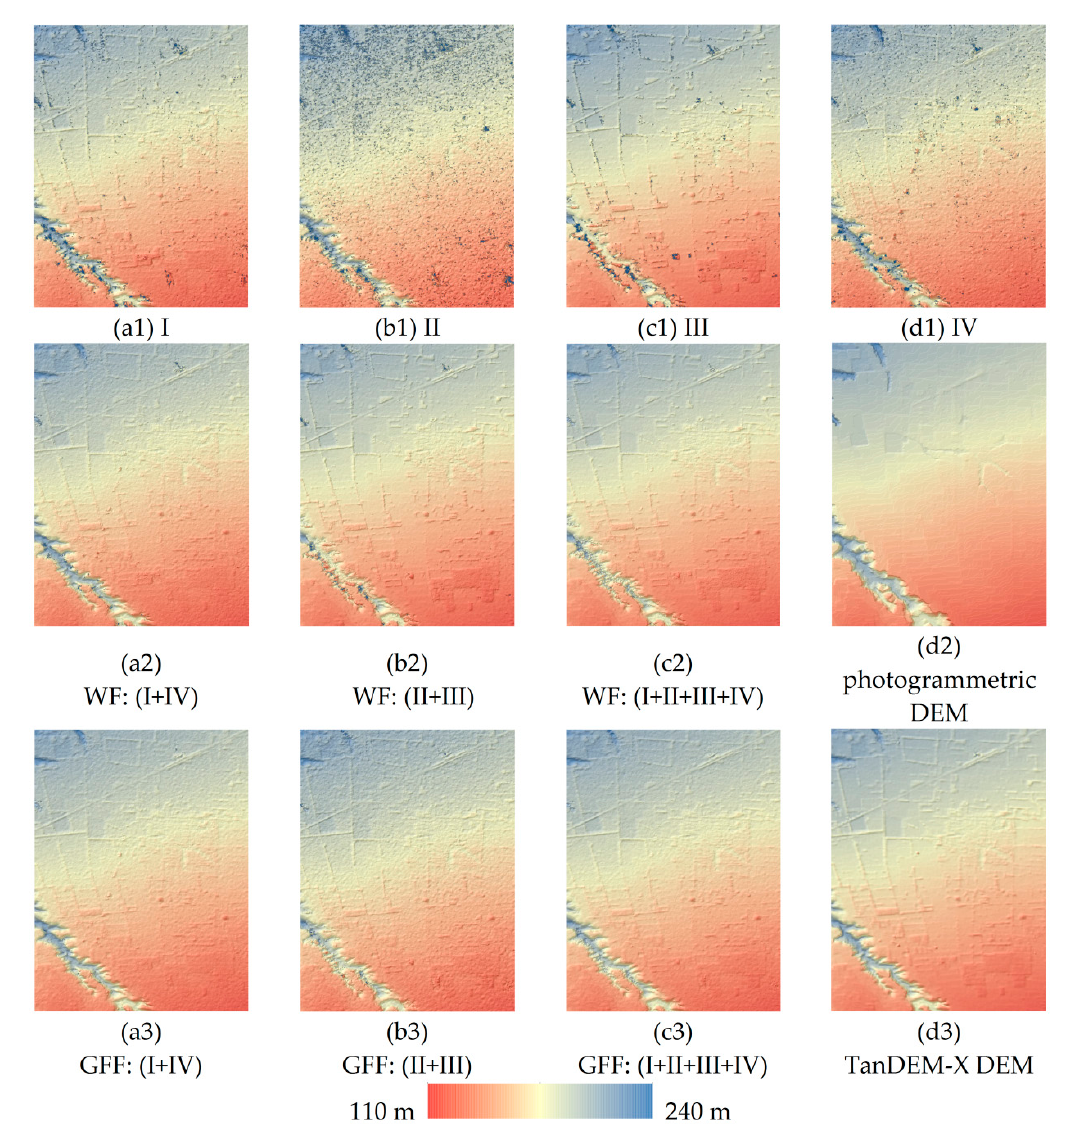
Figure 7. DEM magnifications of the plain area. ( a1 – a4 ) correspond to single-baseline InSAR DEMs I ( B n = 251 m), II ( B n = 157 m), III ( B n = 471 m), and IV ( B n = 237 m), respectively. ( a2 , a3 ) are the fused DEMs of I and IV; ( b2 , b3 ) are the fused DEMs of II and III; ( c2 , c3 ) are the fused DEMs of I, II, III, and IV; ( a2 , b2 , c2 ) are fused by weighted average; and ( a3 , b3 , c3 ) are fused by guided filter. The cell sizes of ( a1 – a3 , b1 – b3 , c1 – c3 , d1 ) are 5 m. ( d2 ) is the photogrammetric DEM with a cell size of 1 m and ( d3 ) is the TanDEM-X DEM with a cell size of 12 m. The spatial dimension of each subfigure is about 2.3 km in width by 4.1 km in height.